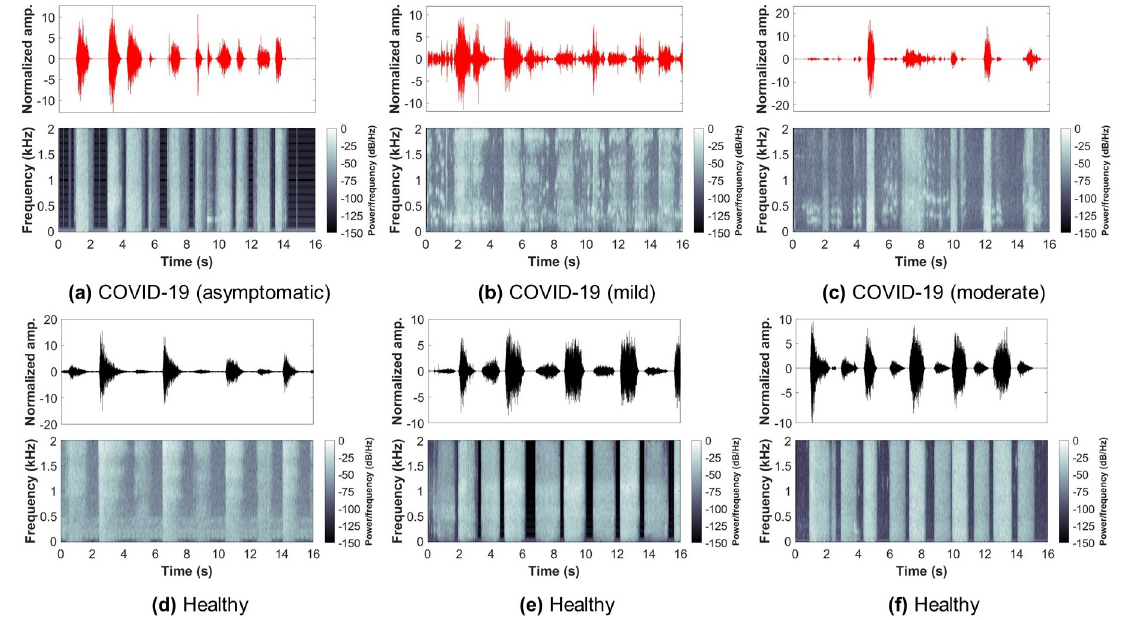
Fig 3. Examples from the deep breathing sounds recorded via smartphone microphone along with their corresponding spectrograms. Showing: (a-c) COVID-19 subjects (asymptomatic, mild, moderate), (d-f) healthy subjects.